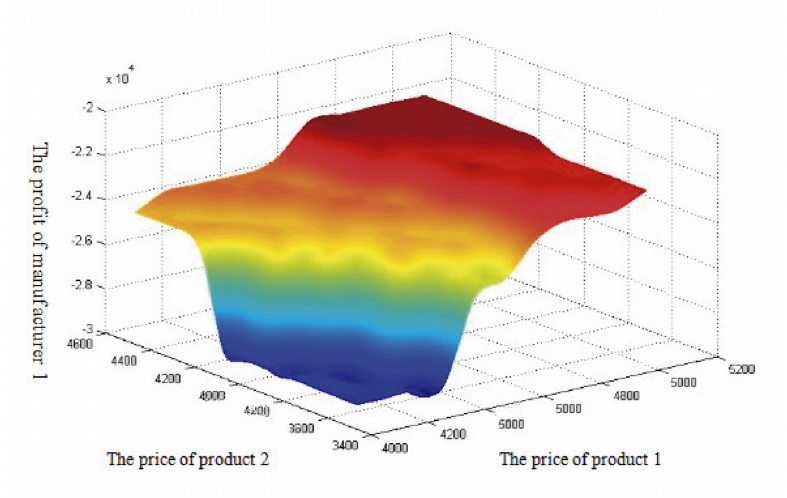
Figure 1. The curve of Manufacturer 1’s profit change with Lenovo computer and HP computer prices